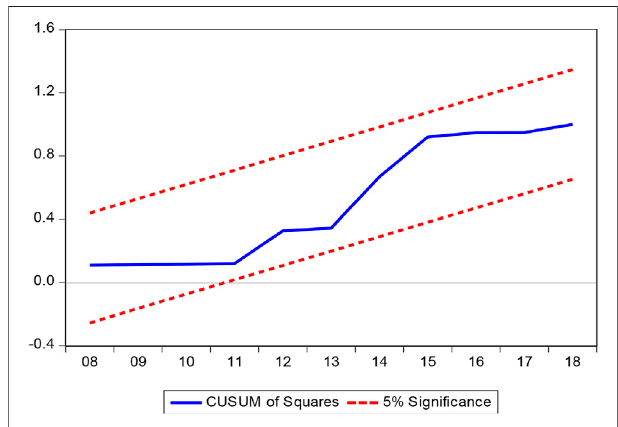
FIGURE 5 | The plot of the cumulative sum of squares of recursive residuals.